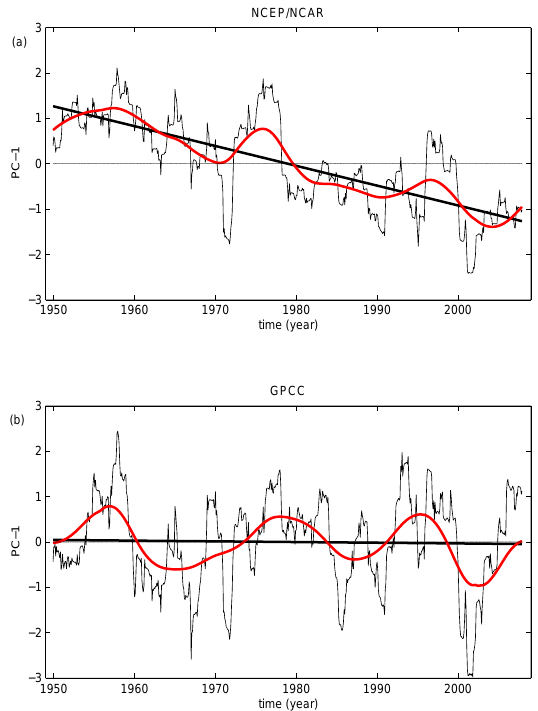
Fig. 4. Principal component analysis of the SPI field. First prin- cipal component score time series (PC-1) for: (a) NCEP/NCAR, (b) GPCC. Straight lines denote the fitting linear trends, while red lines the reconstructed PC-1 time series using only the leading SSA component.